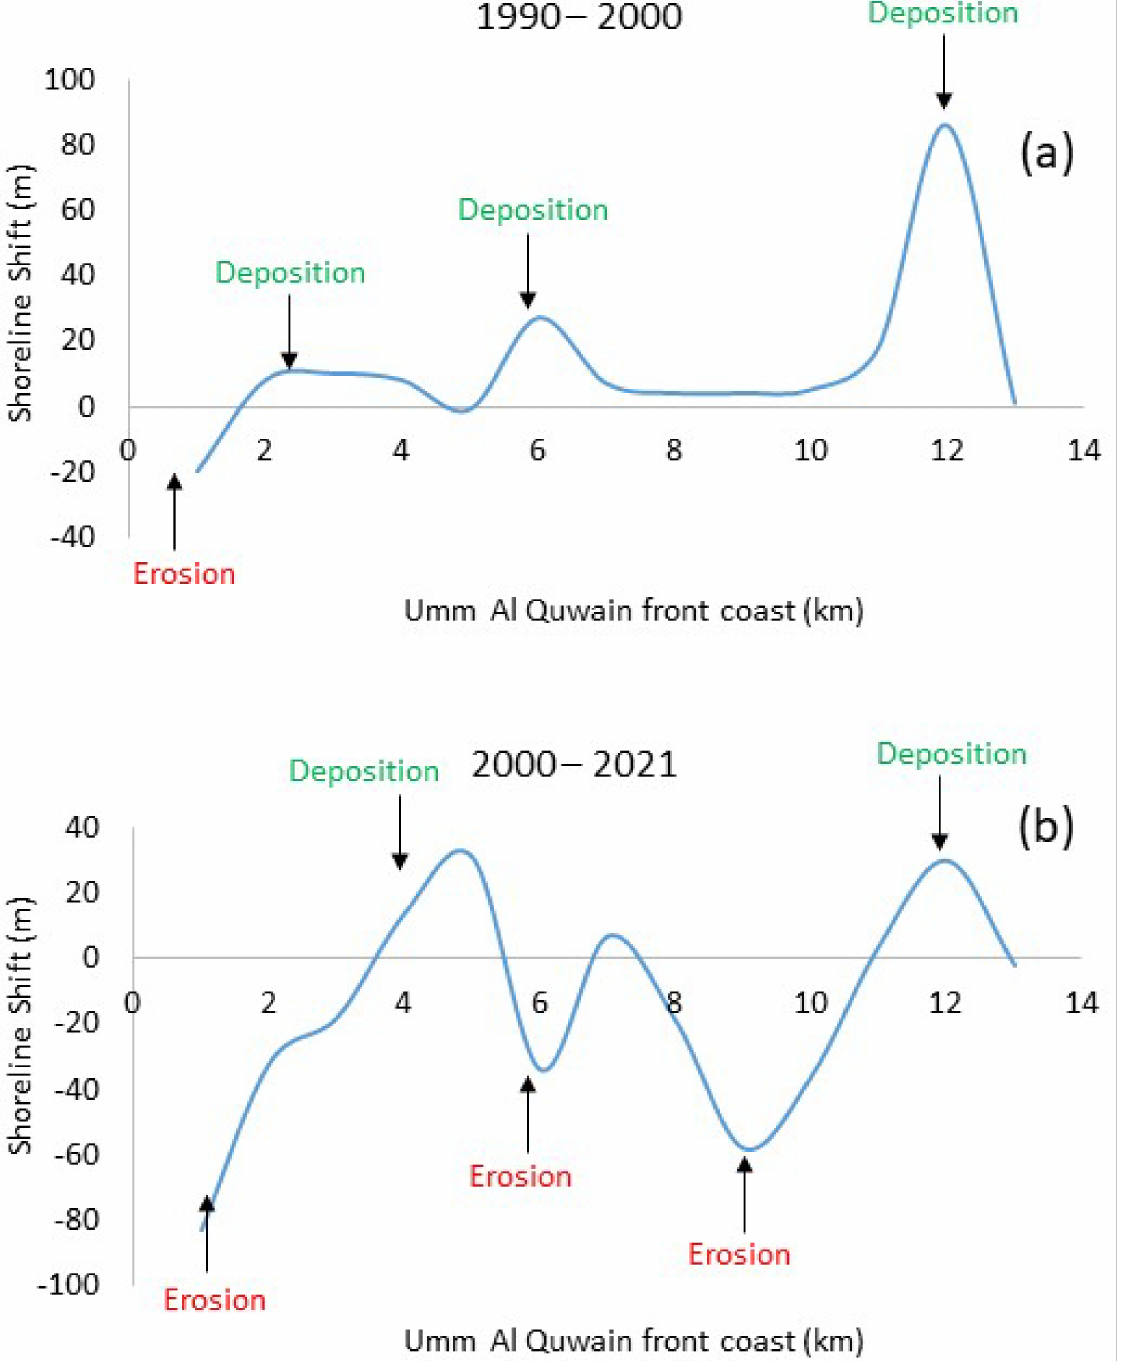
Figure 10. Shoreline shift changes along the 14 km long UAQ front coast from ( a ) 1990–2000 and ( b ) 2000–2021. The positive coastline shift caused by accumulation is greater in the upper panel ( a ), whereas the negative coastline shift caused by erosion is greater in the lower panel ( b